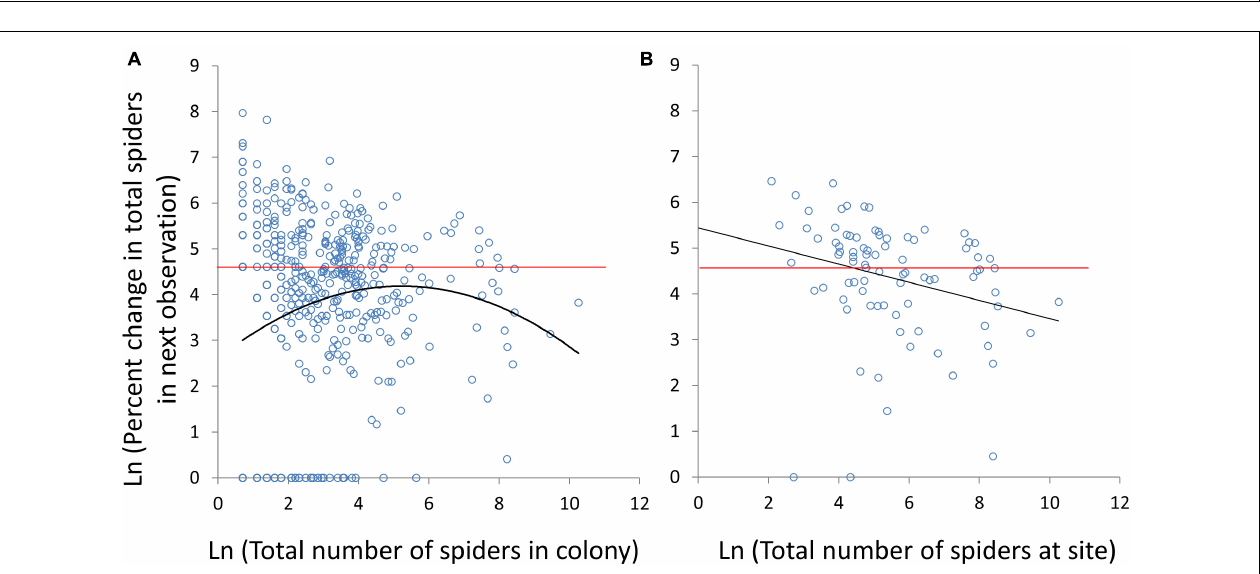
FIGURE 6 | The correlation between the number of adult or subadult females in the colony and the number of egg sacs per female. All colonies are included in panel (A) , while colonies that failed to reproduce at all are excluded in panel (B) . Significant linear correlations are indicated by solid lines, while a non-significant quadratic effect is indicated by a dashed line.